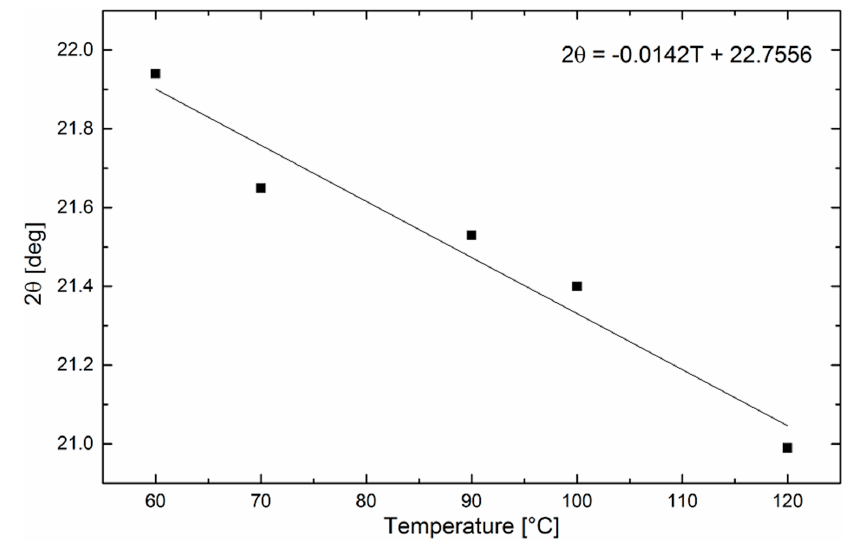
Figure 4. Position of an amorphous halo as a function of the temperature of melted PEO.